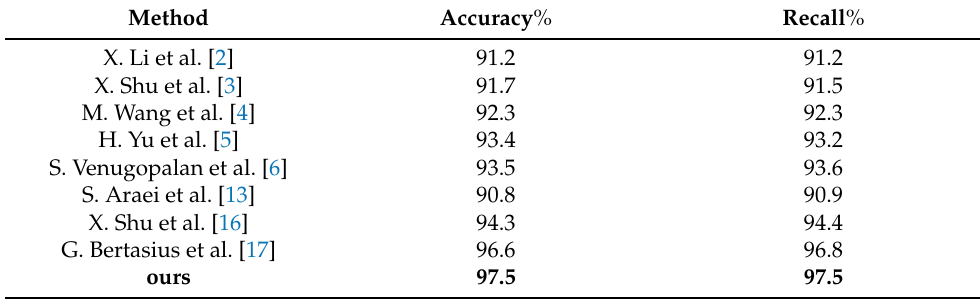
Table 3. Comparison results of football